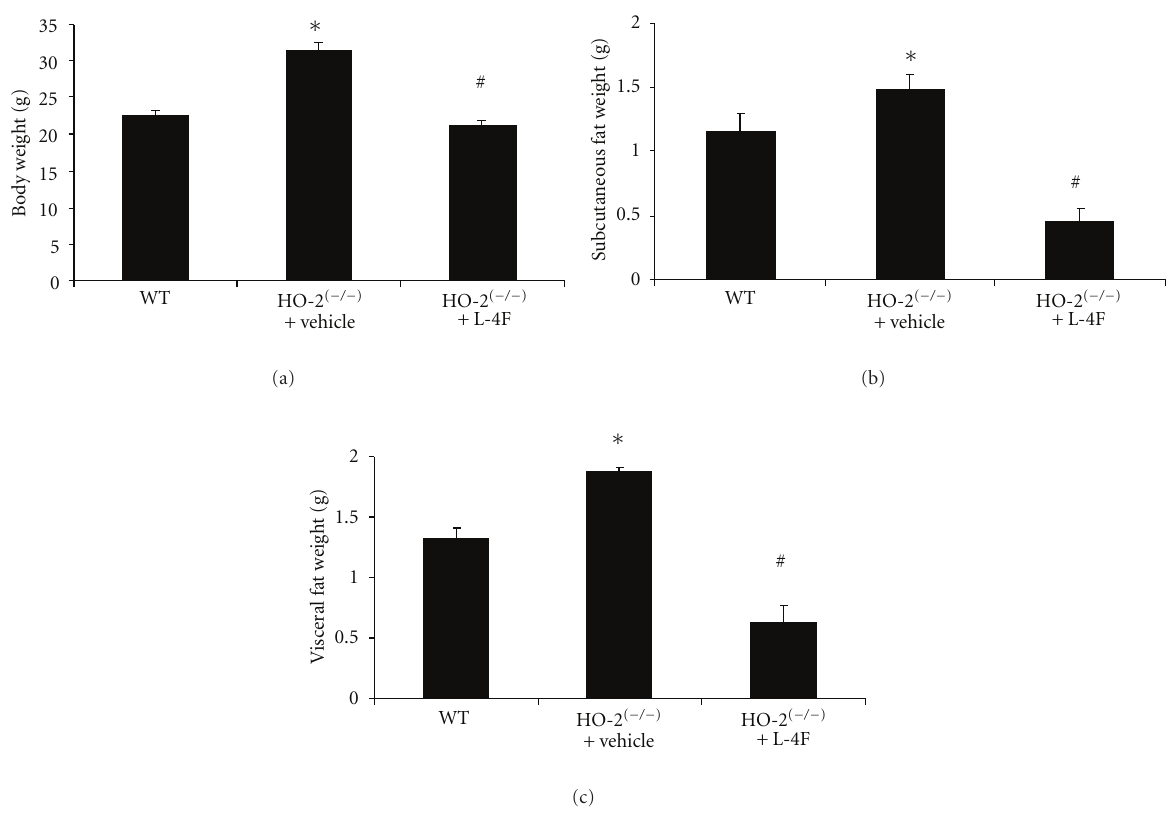
Figure 1: E ff ect of HO-2 deletion on body weight and adiposity. Figures showing wild-type (WT), HO-2 null (HO-2 ( − / − ) ) and L-4F treated HO-2 ( − / − ) mice (HO-2 ( − / − ) + L-4F) after 6 weeks of treatment. (a) E ff ect of L-4F on body weight on HO-2 ( − / − ) mice. (b) E ff ect of L-4F on subcutaneous body weight on HO-2 ( − / − ) mice. (c) E ff ect of L-4F on visceral body weight on HO-2 ( − / − ) mice. Results are means ± SE, n = 6, ∗ P < 0 . 05 versus WT; # P < 0 . 05 versus HO-2 ( − / − ) .